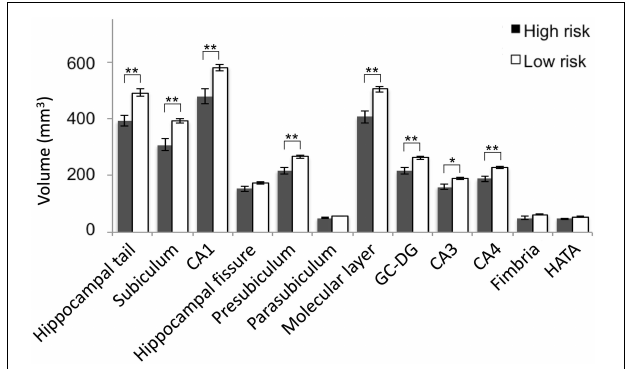
FIGURE 4 | Hippocampal subfield volumes by assumed Alzheimer’s disease (AD) risk. Mean subfield volumes of the high and low risk group with SEM and levels of significance for FDR-corrected p -values. SEM, standard error of mean; FDR, false discovery rate; *, FDR-corrected p < 0.05; **, FDR-corrected p < 0.01. CA, cornu ammonis; GC-DG, granule cell layer of the dentate gyrus; HATA, hippocampus-amygdala-transition-area.